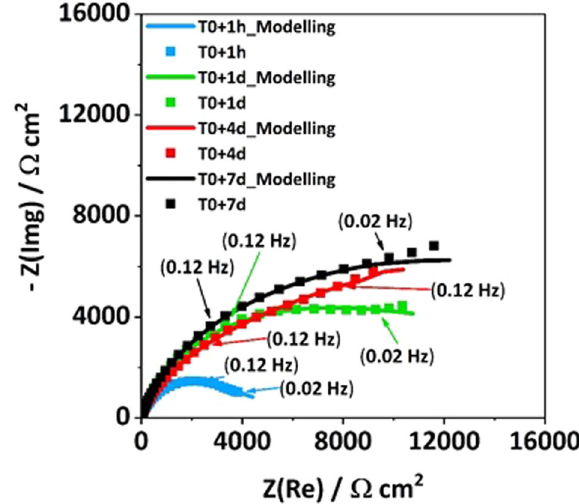
Fig. 10 Nyquist diagrams measured during 7 days of cathodic polarization at − 0.8 V versus SCE. Imaginary (Z(img)) is plotted in function of the real parts (Z(Re)) of the impedance, under static, at 20 °C in natural aeration and static conditions, after 1 h, 1 day, 4 days and 7 days of continuous cathodic